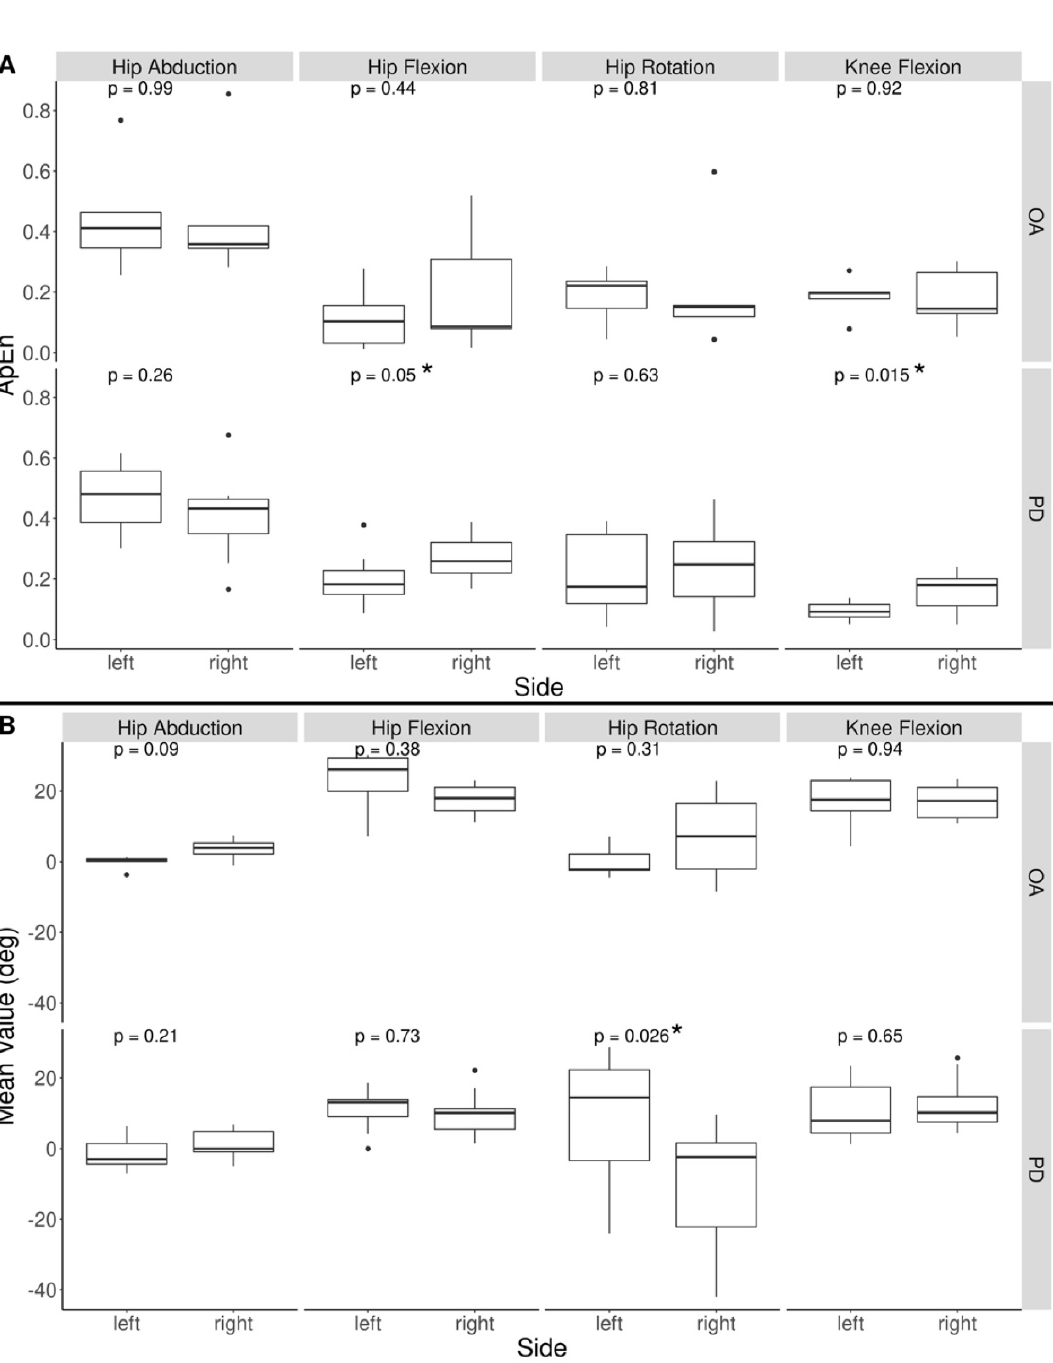
right body movements. No other significant difference in the means of left and right body movement was found in either group.